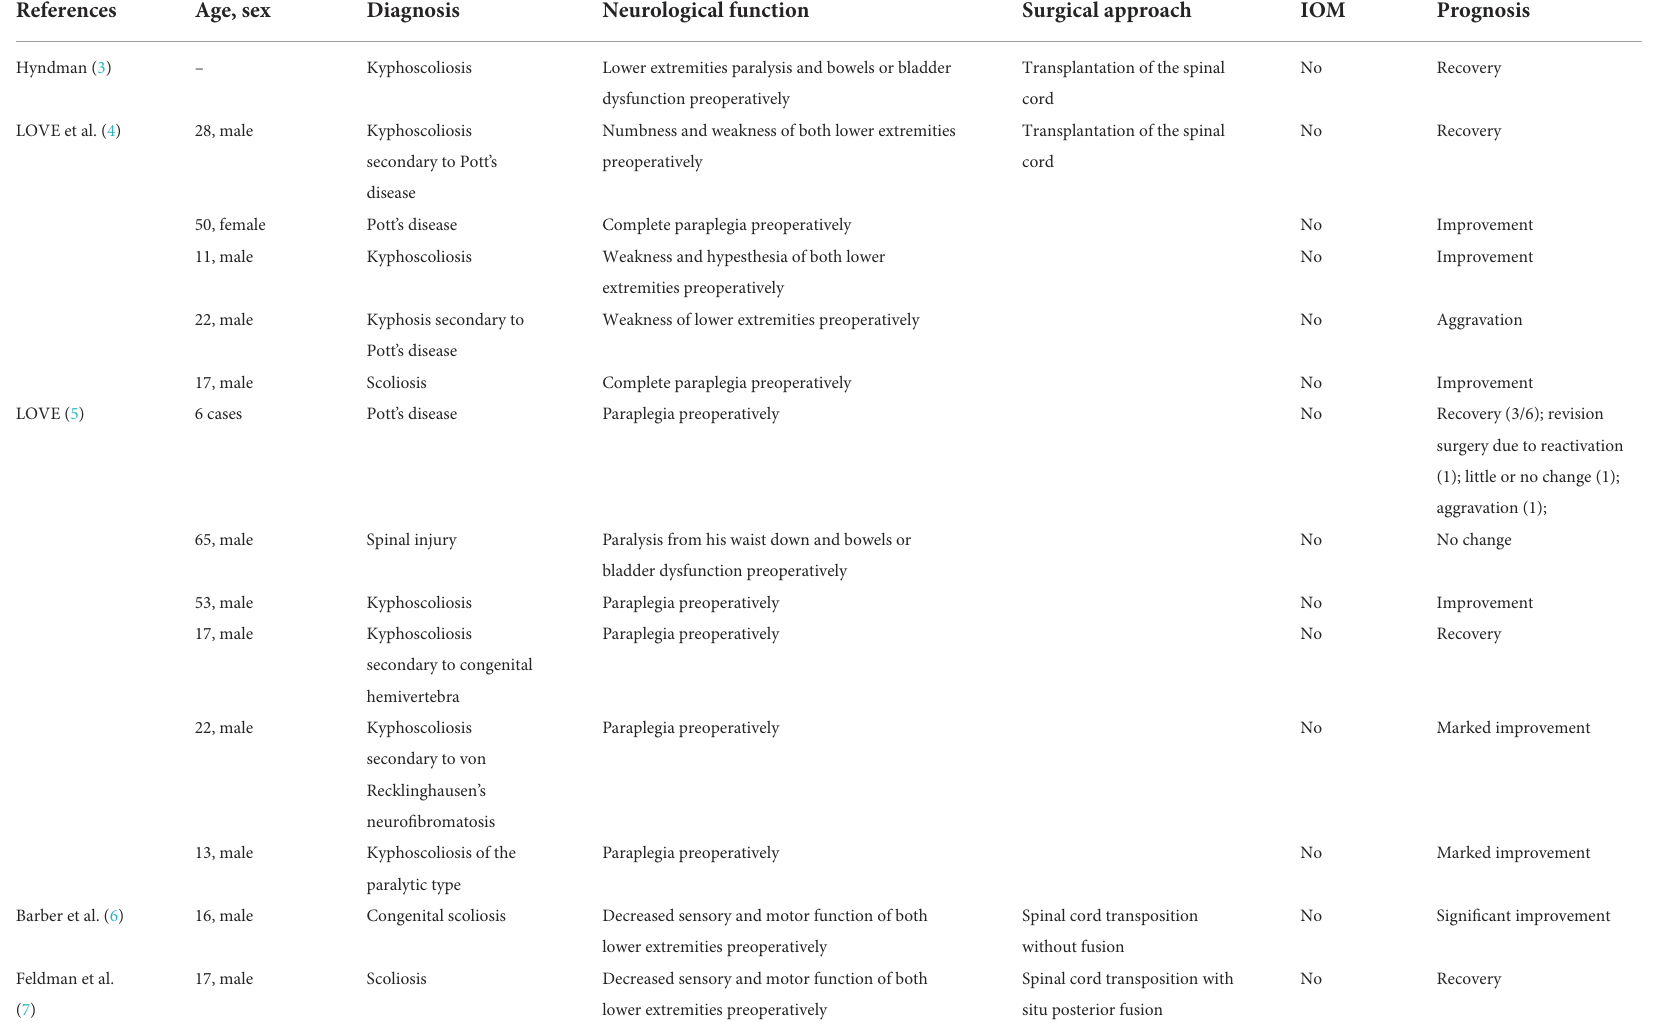
TABLE 1 Literature review with summary of previously reported cases and our cases of transposition of the spinal